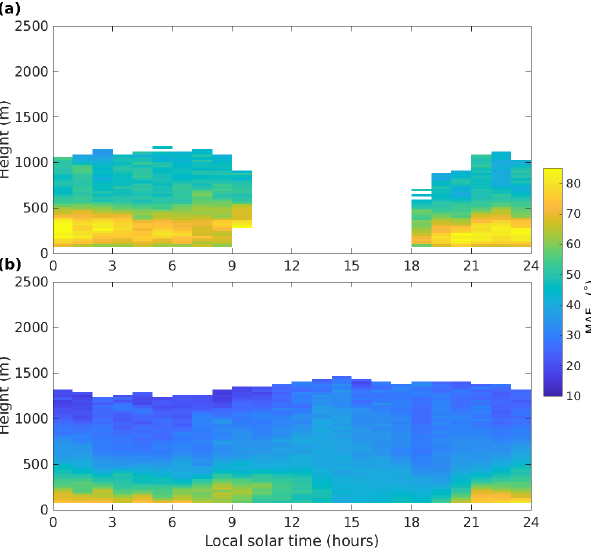
Figure 9. Diurnal composites of mean absolute wind direction er- ror in Granada when a mountain breeze is (a) detected and (b) not detected in the Doppler lidar data. Time refers to approximate local solar time.